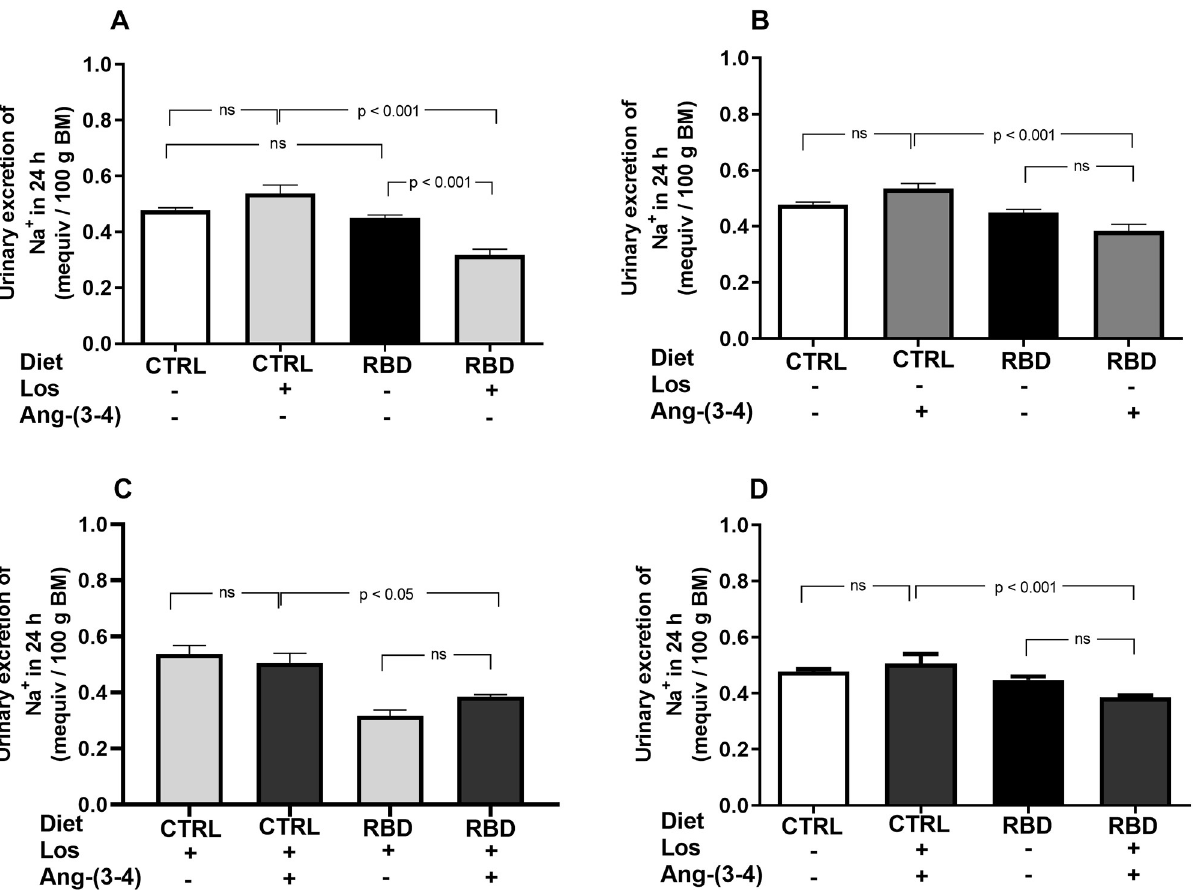
Fig 10. Urinary Na + excretion (U Na V). Urinary Na + excretion in 24 h was calculated from V ur in 24 h/100 g BM and [Na + ] ur (Figs 8 and 9, respectively). (A) Responses to Losartan. Comparison of U Na V in CTRL and RBD rats without chronic administration of Losartan, and effects of Losartan administration, as indicated on the abscissa . (B) Responses to Ang-(3–4). Effects of oral administration of a single dose of Ang-(3–4) on the U Na V by CTRL and RBD rats, as indicated on the abscissa . (C) Responses to Ang-(3–4) in rats previously treated with Losartan. Effects of oral administration of a single dose of Ang-(3–4) on the U Na V by CTRL and RBD rats previously treated with Losartan, as indicated on the abscissa . (D) Effects of combined Losartan+Ang-(3–4) administration. Comparison of U Na V between untreated CTRL and RBD rats vs . CTRL and RBD rats that were chronically given Losartan and a single dose of Ang-(3–4), as indicated on the abscissa . Bars are mean ± SEM; n = 5 (CTRL), n = 7 (RBD), n = 5 (CTRL+Los), n = 6 (RBD+Los), n = 5 (CTRL+Ang-(3–4)), n = 8 (RBD+Ang-(3–4)), n = 5 (CTRL+Los+Ang-(3–4)), n = 6 (RBD+Los+Ang-(3–4)). Differences between means were analyzed using one-way ANOVA followed by Bonferroni’s test for selected pairs. P values are given within the